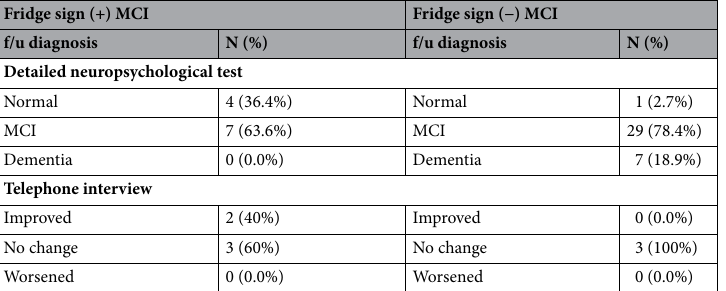
Table 3. Comparison of the change in cognitive function between ‘fridge sign’-positive MCI patients and ‘fridge sign’-negative MCI patients. Telephone interviews were evaluated by the IQCODE with a cut-off value < 3.00 indicative of improvement and > 3.44 indicative of worse cognitive function. MCI mild cognitive